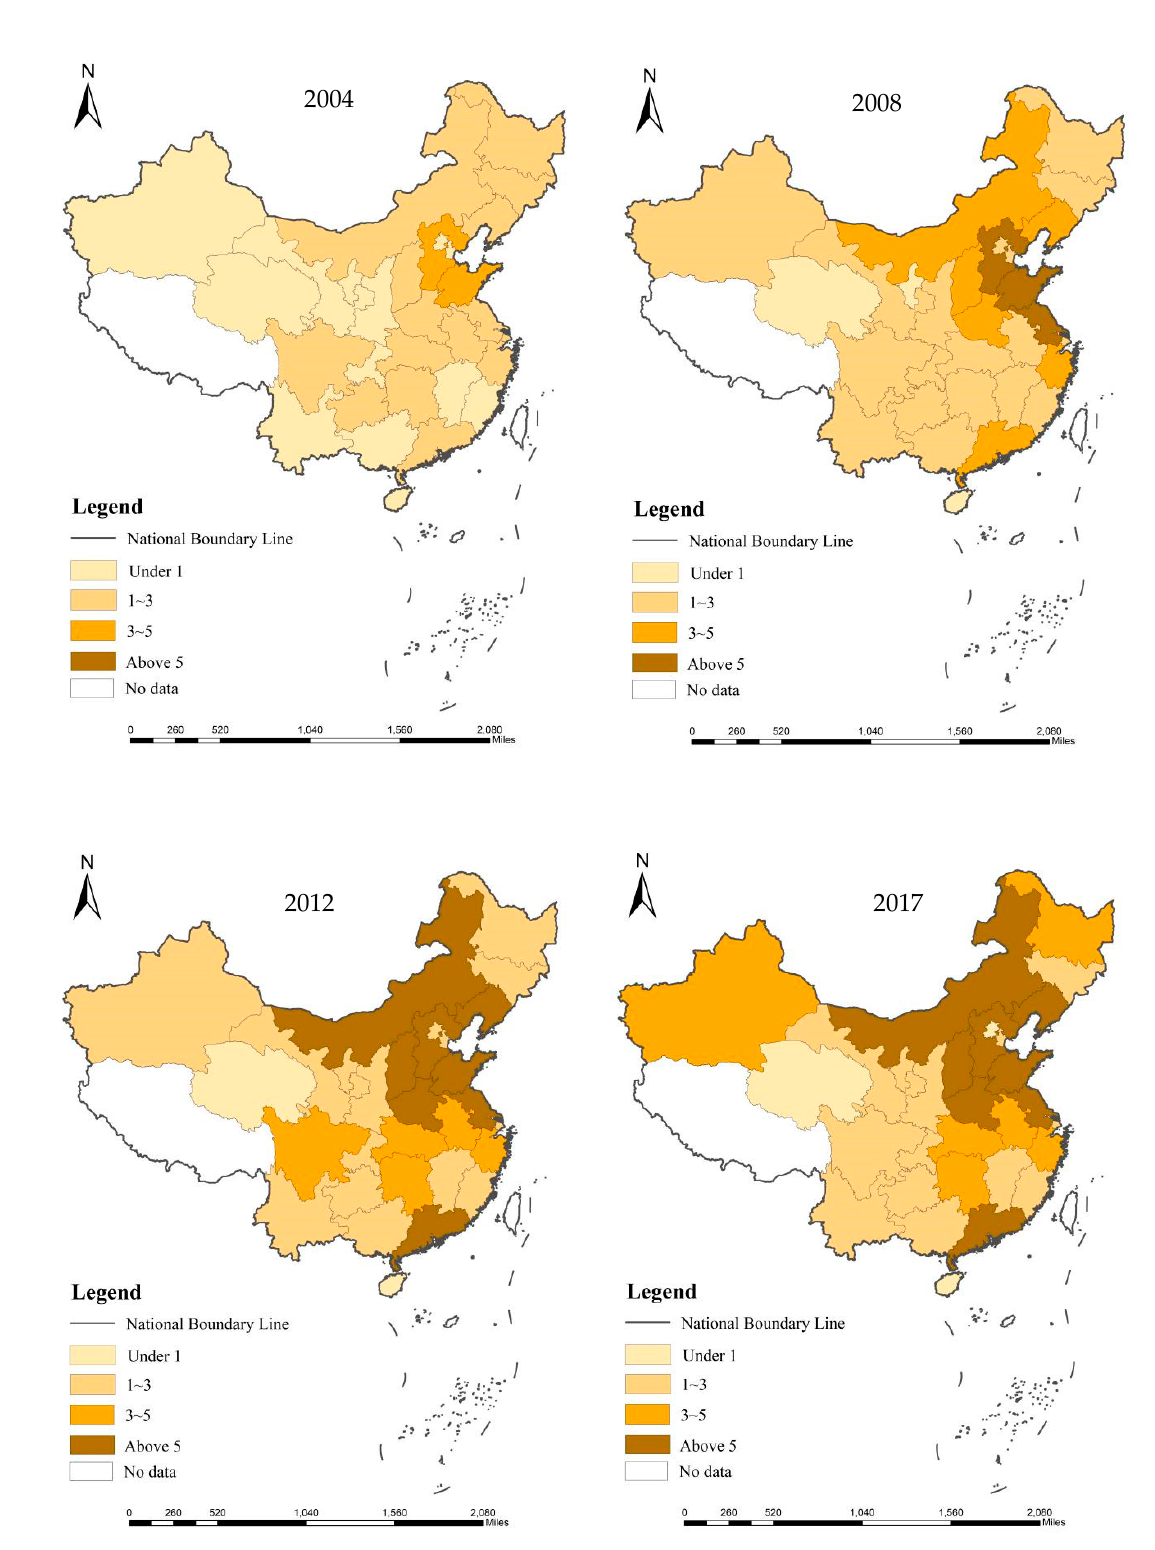
Figure 1. China provincial carbon emission intensity from 2004 to 2017.